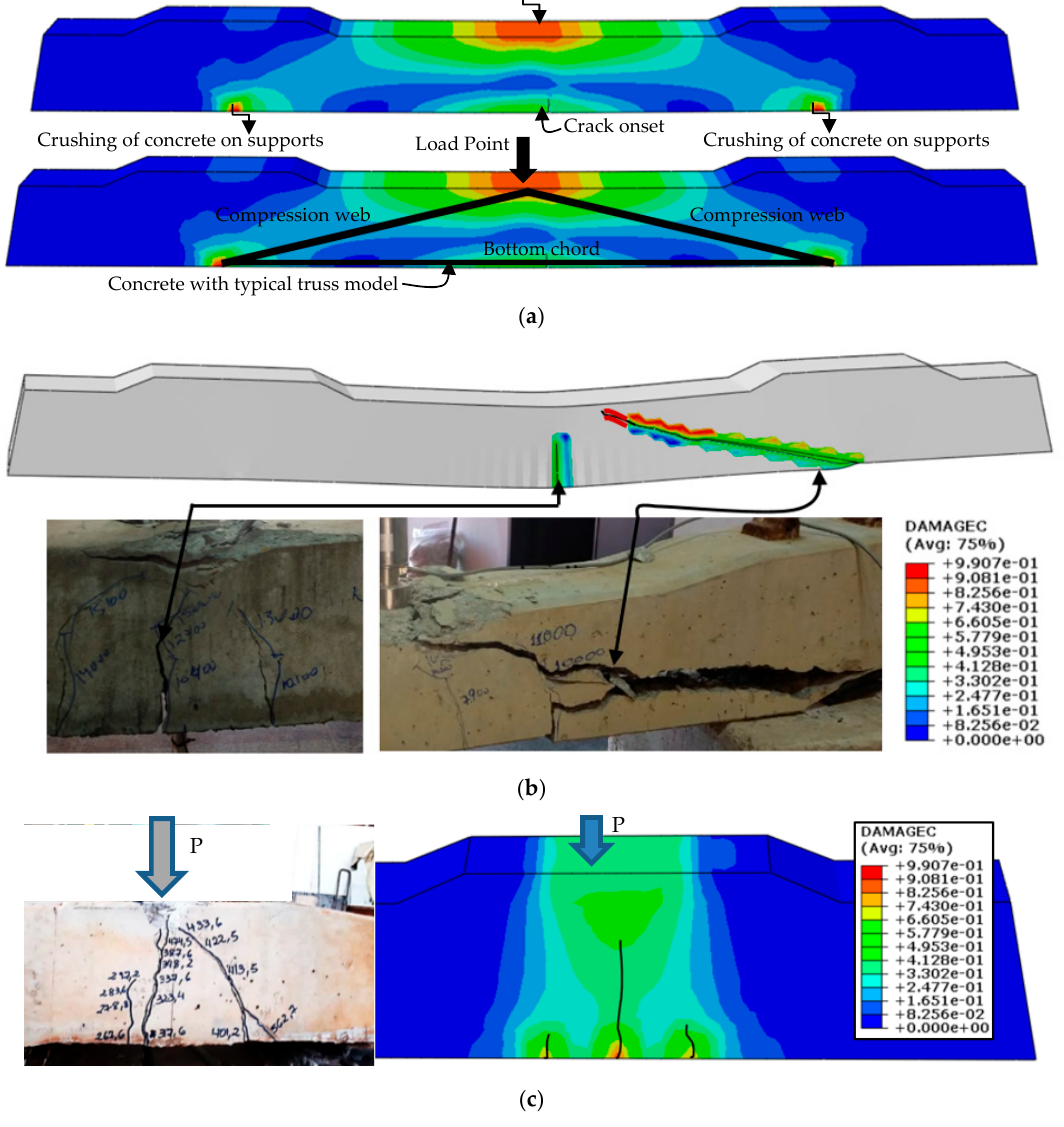
Figure 14. Comparison of failure modes: ( a ) idealization of the sleeper failure model to the plane truss; ( b ) comparison of failure modes of the bent sleeper; and ( c ) comparison of sleeper failure modes, with load applied at the support.